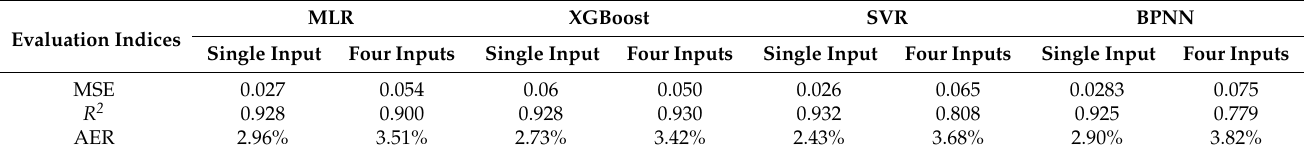
Table 3. Comparison of the predictive effects.